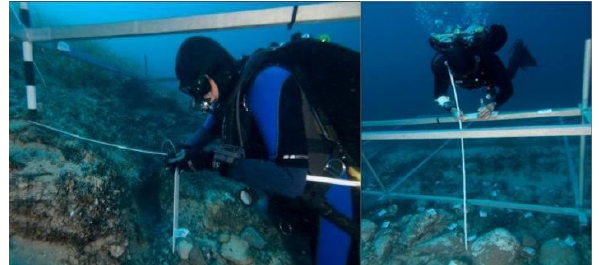
Figure 2. Trilateration and measuring of the depth of the amphoras (photo: J. Kwiatkowski).